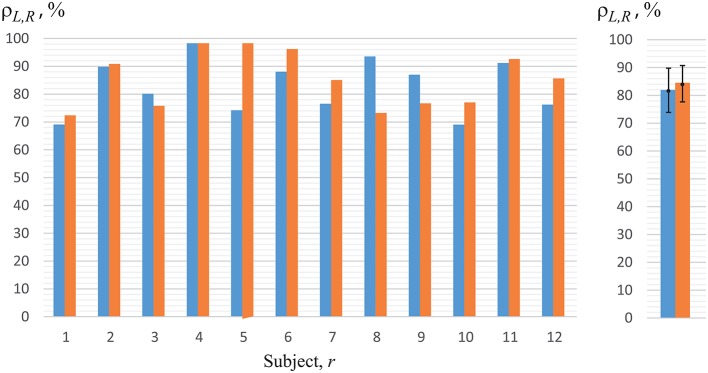
Recognition accuracy for left-oriented (left blue columns), ρL, and right-oriented (right orange columns), ρR, Necker cube perception for all of the 12 subjects using ANN trained on the EEG of the same subject (h = r). The right panel represents the data averaged over all persons under study.